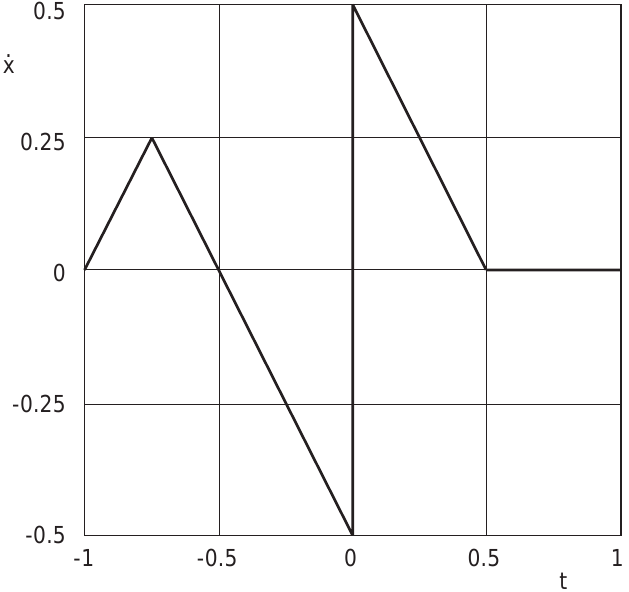
Fig. 3. Time history of the relative velocity of the object corresponding to the optimal pre-acting control.